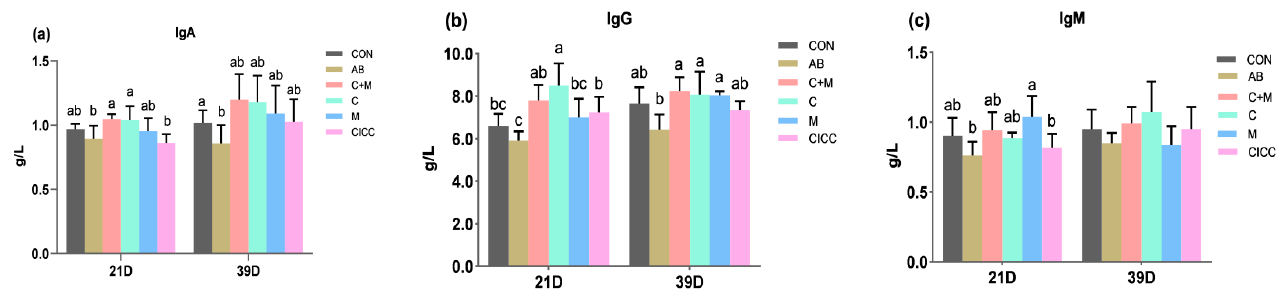
Figure 2. Effect of Bacillus amyloliquefaciens LFB112 on serum immune factors (g/L) of broiler. Ig = immunoglobulin. ( a ) Effect of Bacillus amyloliquefaciens LFB112 on IgA. ( b ) Effect of Bacillus amyloliquefaciens LFB112 on IgG. ( c ) Effect of Bacillus amyloliquefaciens LFB112 on IgM. Experimental groups assigned were as follows: CON = basal diet; AB (antibiotics) = basal diet + aureomycin 150 mg/kg; C + M = basal diet + LFB112 fermentation dry powder with Bacillus cells + metabolites (5 × 10 8 CFU/g); C = basal diet + LFB112 Bacillus cell powder with removed metabolites (5 × 10 8 CFU/g); M = basal diet + LFB112 metabolite powder with removed Bacillus cells (5 × 10 8 CFU/g); CICC = basal diet + Bacillus subtilis 20 , 179 (5 × 10 8 CFU/g). (a–c) Different letters on standard error bars indicate a significant difference ( p < 0.05). Data are shown as means and standard errors ( n = 6).